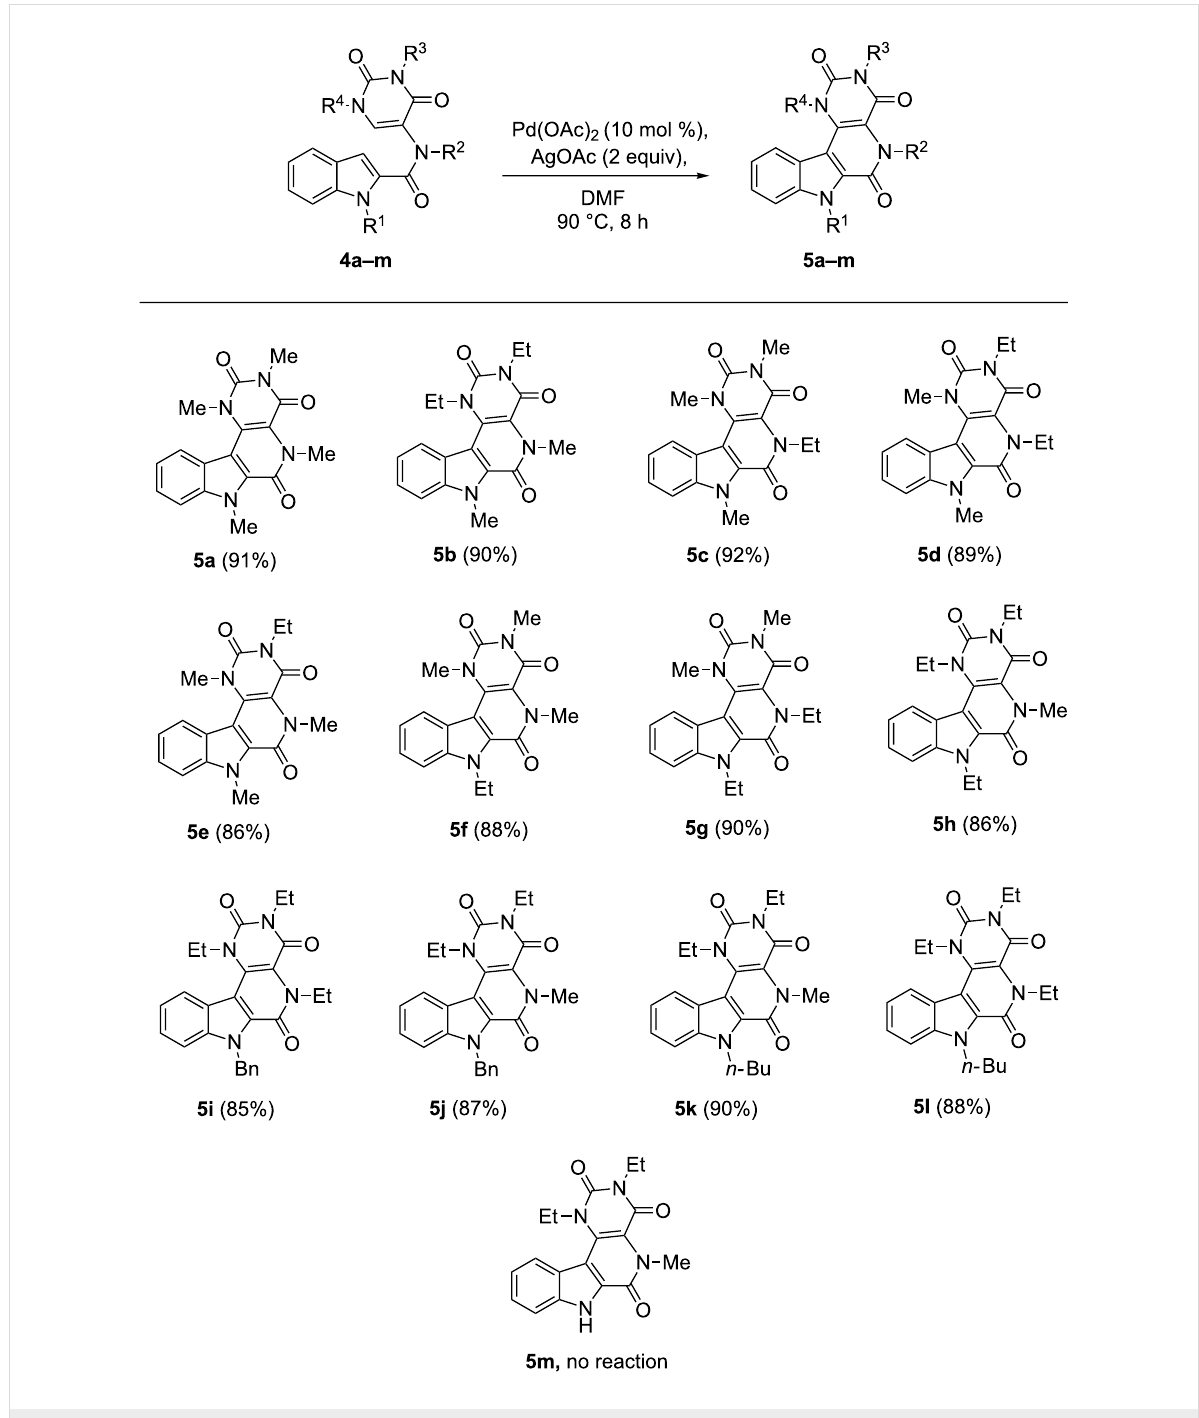
Scheme 2: Synthesis of various β -carbolinone derivatives.